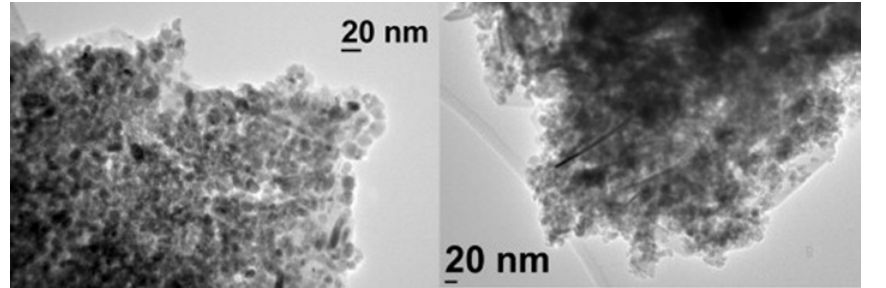
Ni particles (sample C). Reproduced with permission from Elsevier: Journal of 27.5 72.5